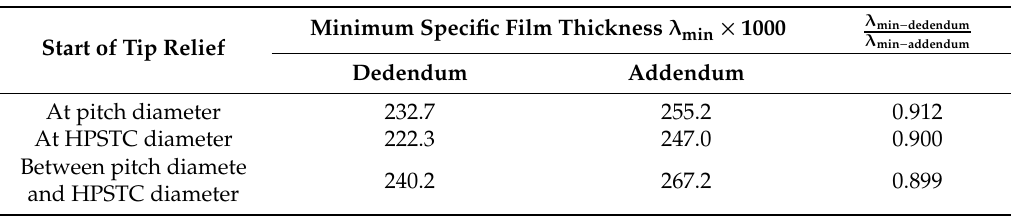
Table 7. Minimum specific film thickness for di ff erent start of tip relief.